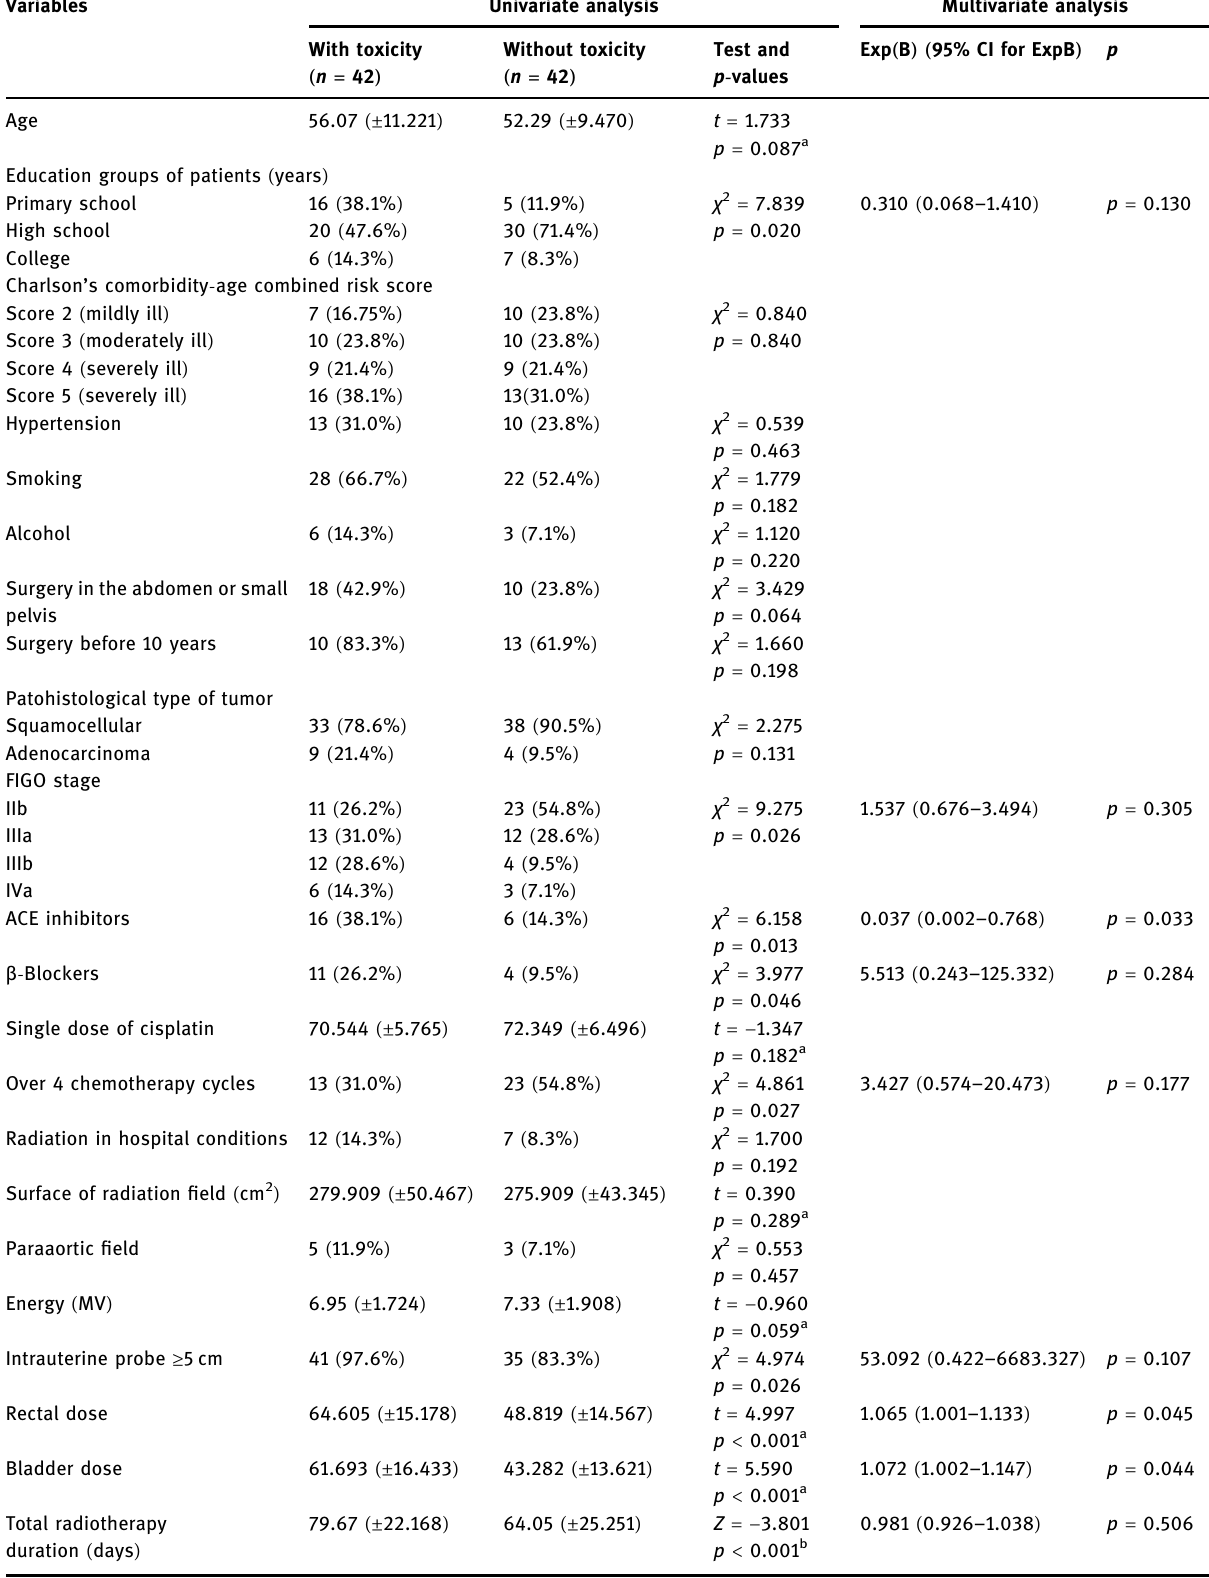
Table 2: Analysis of potential risk factors important for ART onset in patient treated with 2D -